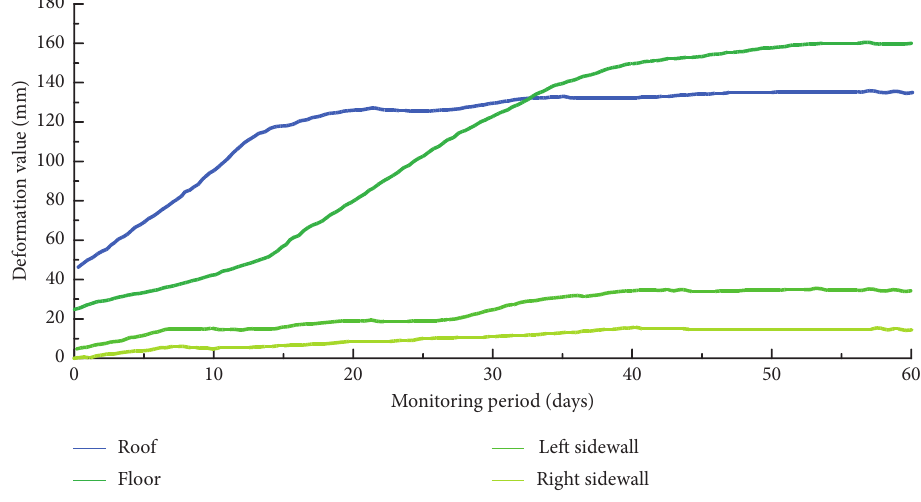
Figure 13: Monitoring data of roadway surface displacement after